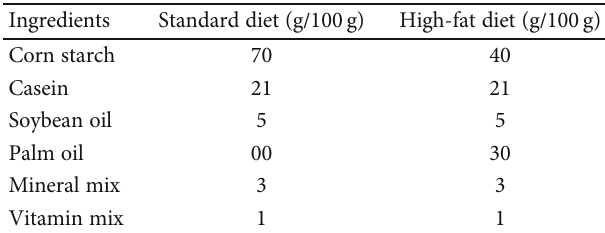
Table 1: Composition of standard and high-fat diets as proposed by Murase et al.